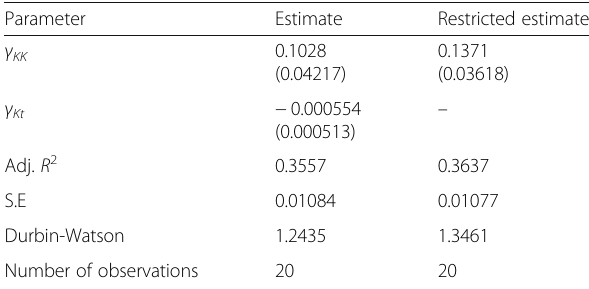
Table 13 Estimation results for the translog production function, Switzerland 1995 – 2014 (standard errors in parentheses)